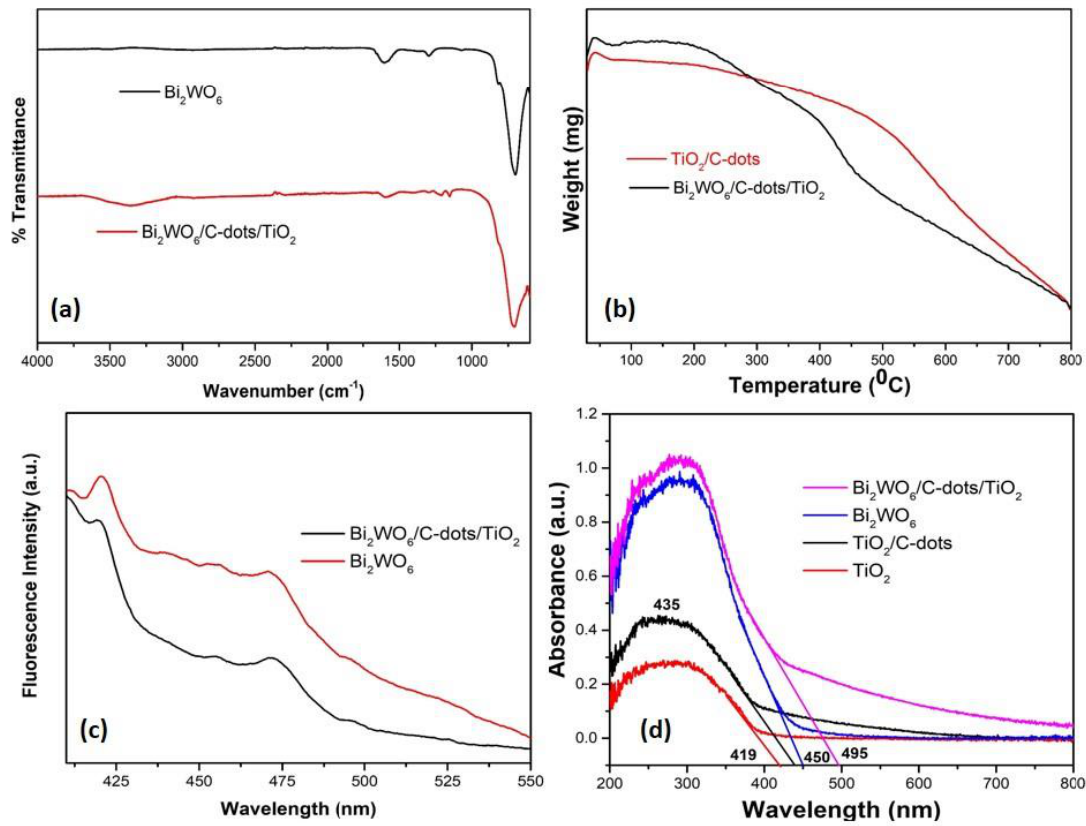
Figure 4. ( a ) FTIR analysis of Bi 2 WO 6 and Bi 2 WO 6 /C-dots/TiO 2 . ( b ) Thermogravimetric analysis of TiO 2 /C-dots and Bi 2 WO 6 /C-dots/TiO 2 . ( c ) PL spectra of Bi 2 WO 6 and Bi 2 WO 6 /C-dots/TiO 2 at λ ex = 360 nm. ( d ) UV-vis DRS analysis of TiO 2 , TiO 2 /C-dots, Bi 2 WO 6 , and Bi 2 WO 6 /C-dots/TiO 2 .